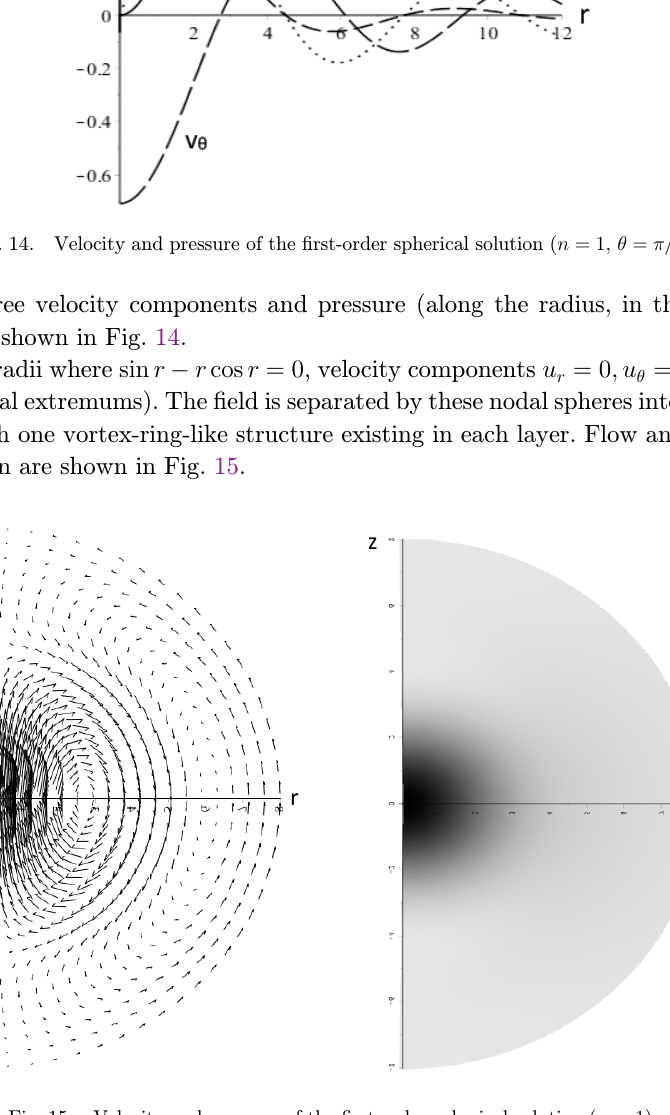
Fig. 15. Velocity and pressure of the ¯rst-order spherical solution ( n ¼ 1